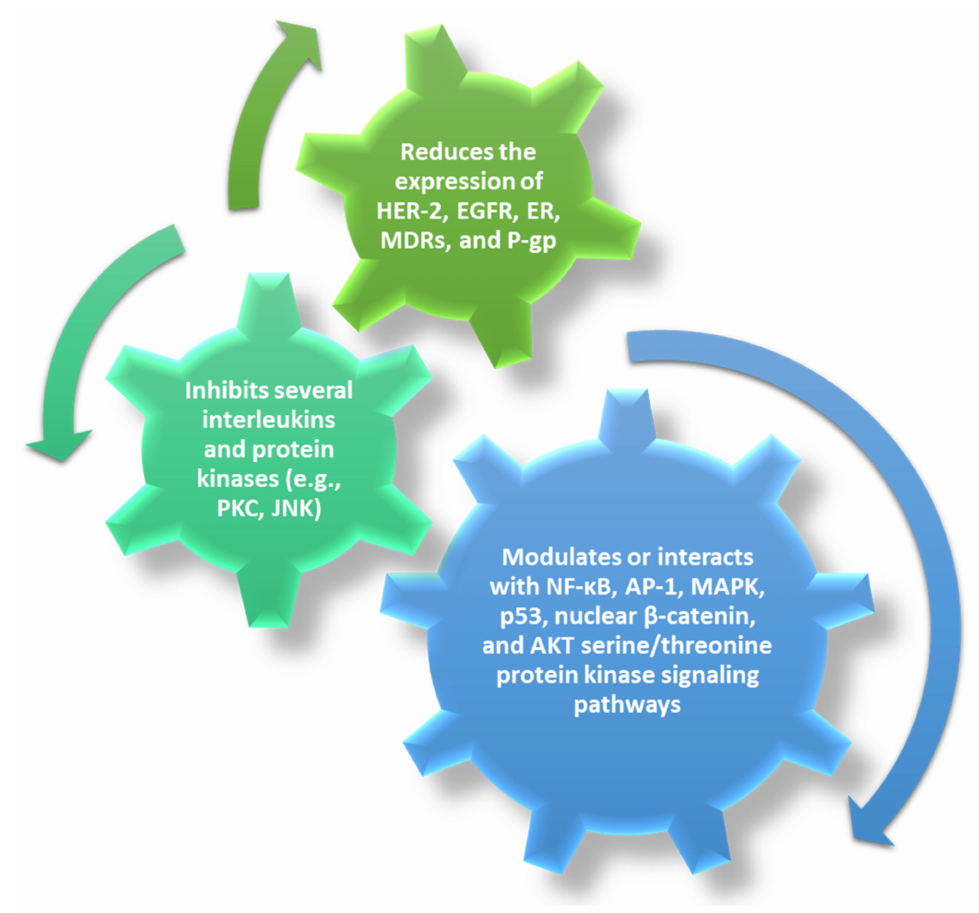
Figure 6. Anticancer effects of curcumin. Created based on information from [39,97]. Table 2. Examples of anticancer nanoparticle formulations based on